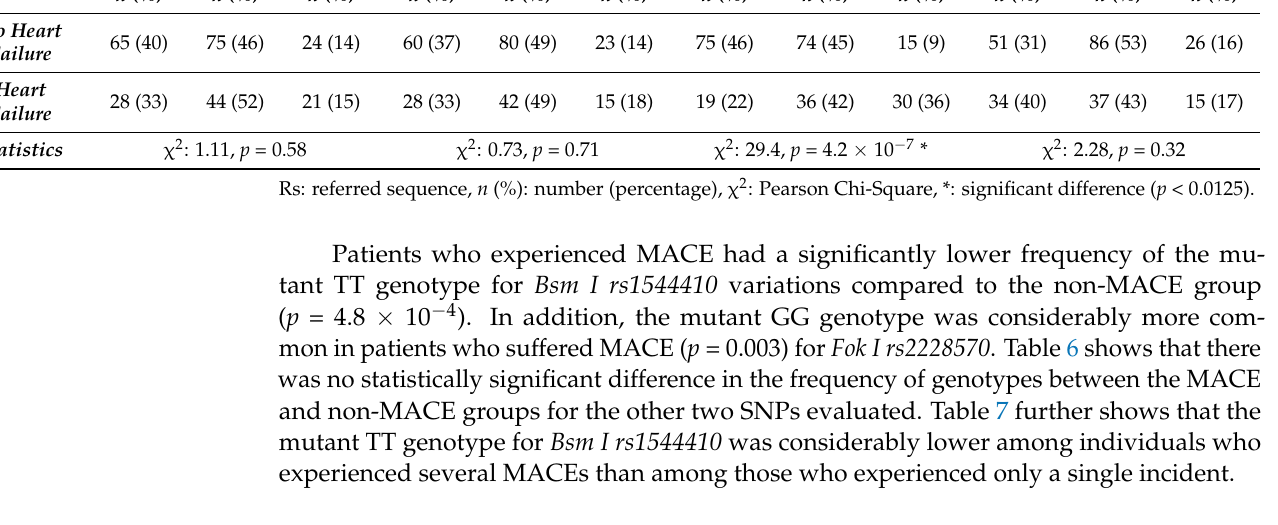
Table 6. Distribution of VDR gene genotypes among MACE and no MACE groups.